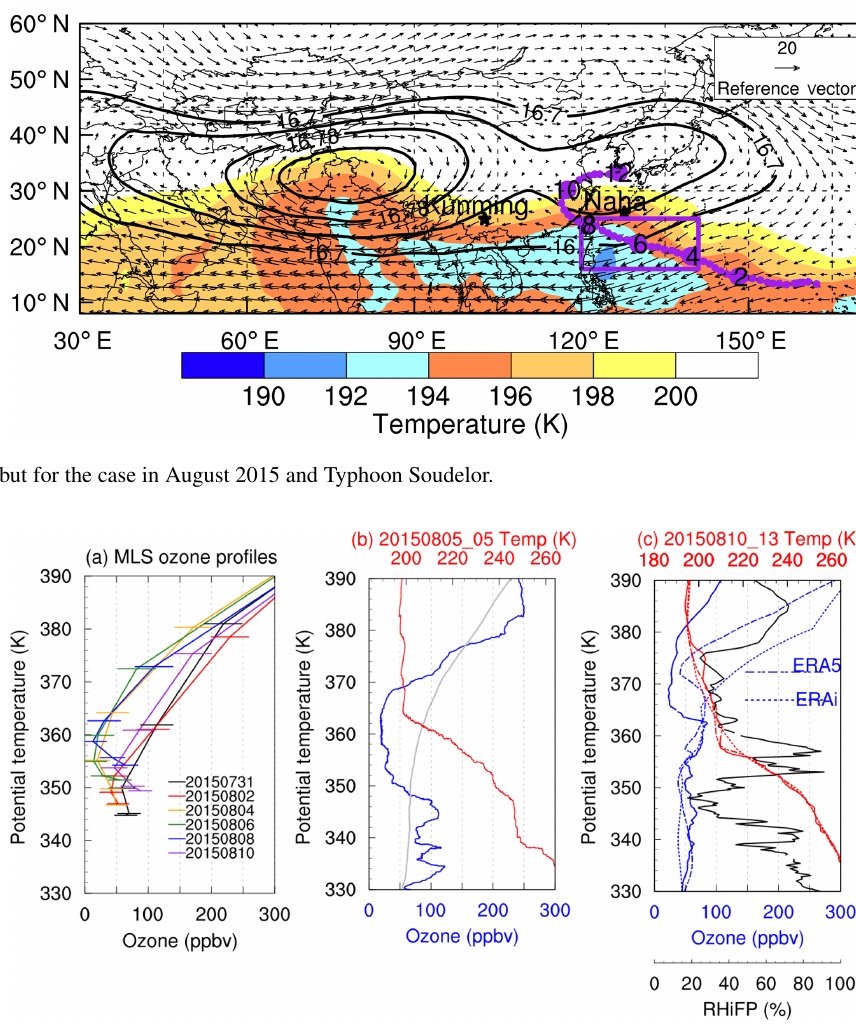
Figure 11. (a) Mean ozone profiles measured from MLS satellite data before, during, and after Soudelor passed through the purple rectangle region of Fig. 10. Profiles of ozone (blue), mean ozone (grey), RH i FP (black), and temperature (red) in (b) Naha and (c) Kunming. Solid line: observation; dashed line: ERA-Interim; dash-dotted line: